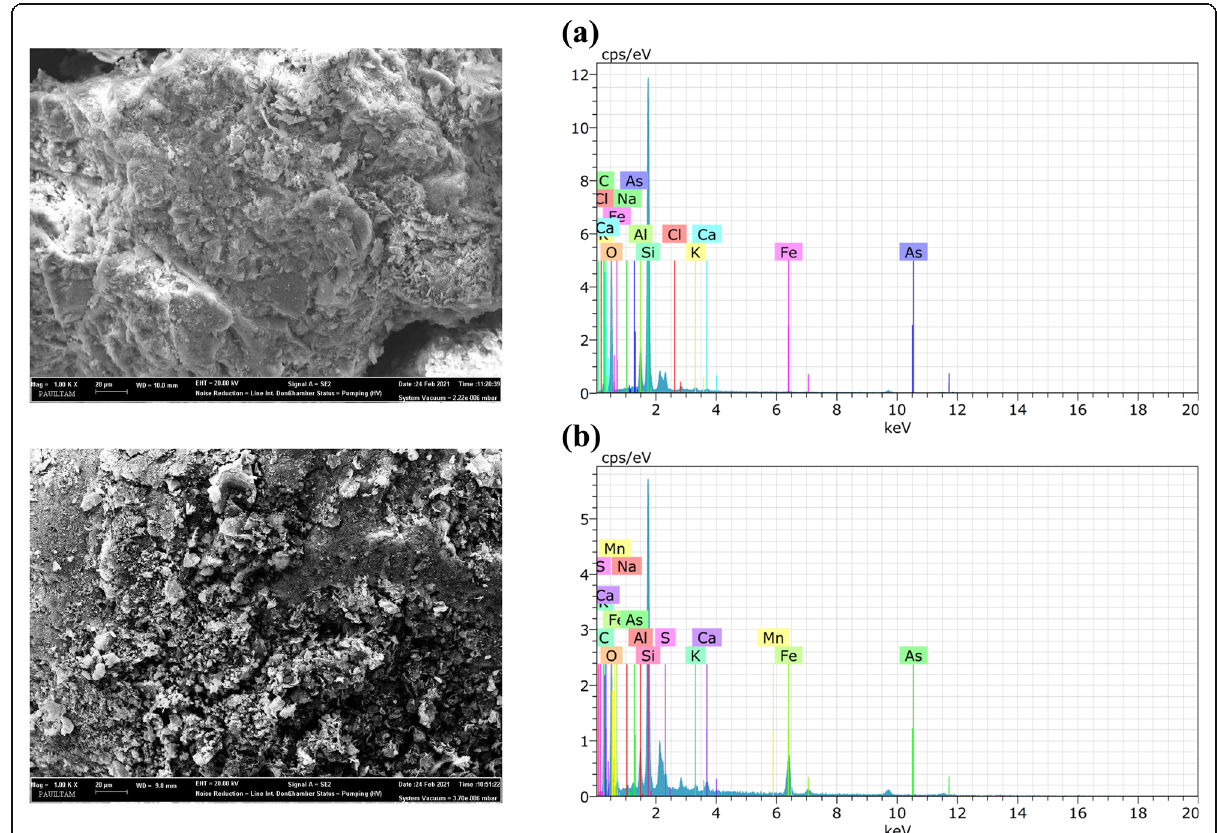
Fig. 9 SEM images and EDS spectra of a GOFeZA and b GOFeZB after arsenate